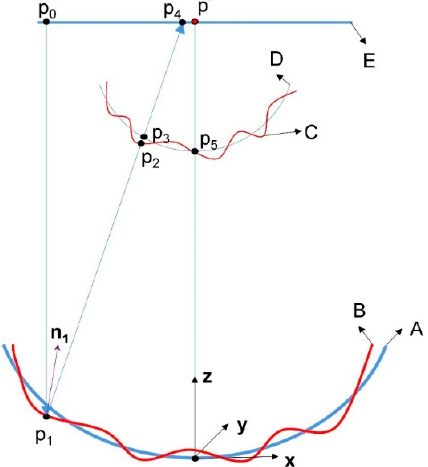
Figure 2. Schematic representation of light propagation in a mirror. Wavefront aberration can comprehensively reflect the imaging performance of the system. The ideal image point of the main light is taken as the Gaussian point. The gaussian sphere is the sphere centered at the Gaussian point with an appropriate radius. Ray